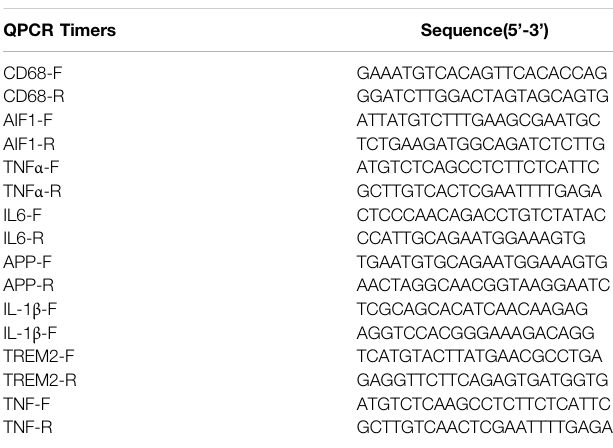
TABLE 1 | Primers used for